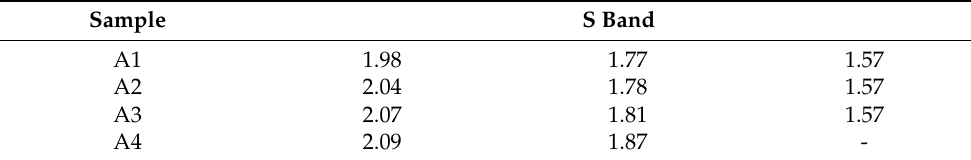
Table 3. PL deconvoluted bands and the position [eV] of the identified peaks. Sample